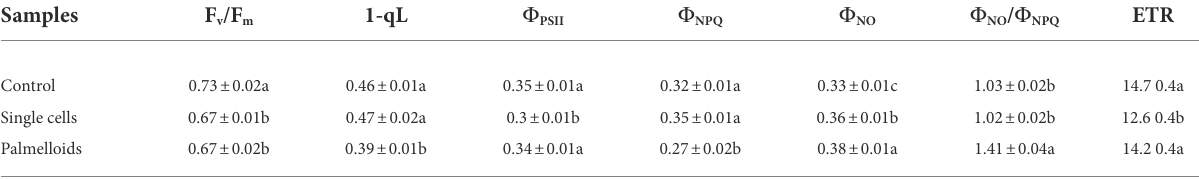
Values represent the mean relative yields (±SE n = 6) of F v /F m - maximum photochemical efficiency, 1-qL - excitation pressure, Ф PSII - efficiency of PSII, Φ NPQ - non-photochemical quenching, Ф NO - non-regulated energy dissipation and electron transport rates - ETR. Values followed by different letters are significantly different, as determined by ANOVA and Tukey’s test ( p <